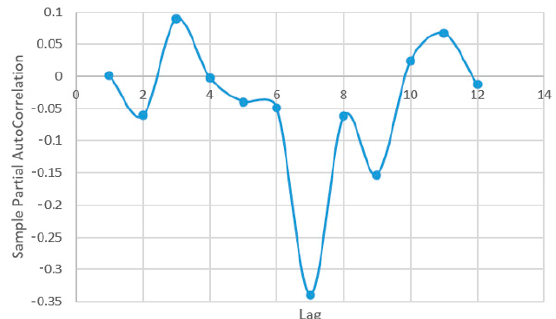
Figure A5. The AC with transformation in square roots—AH series.